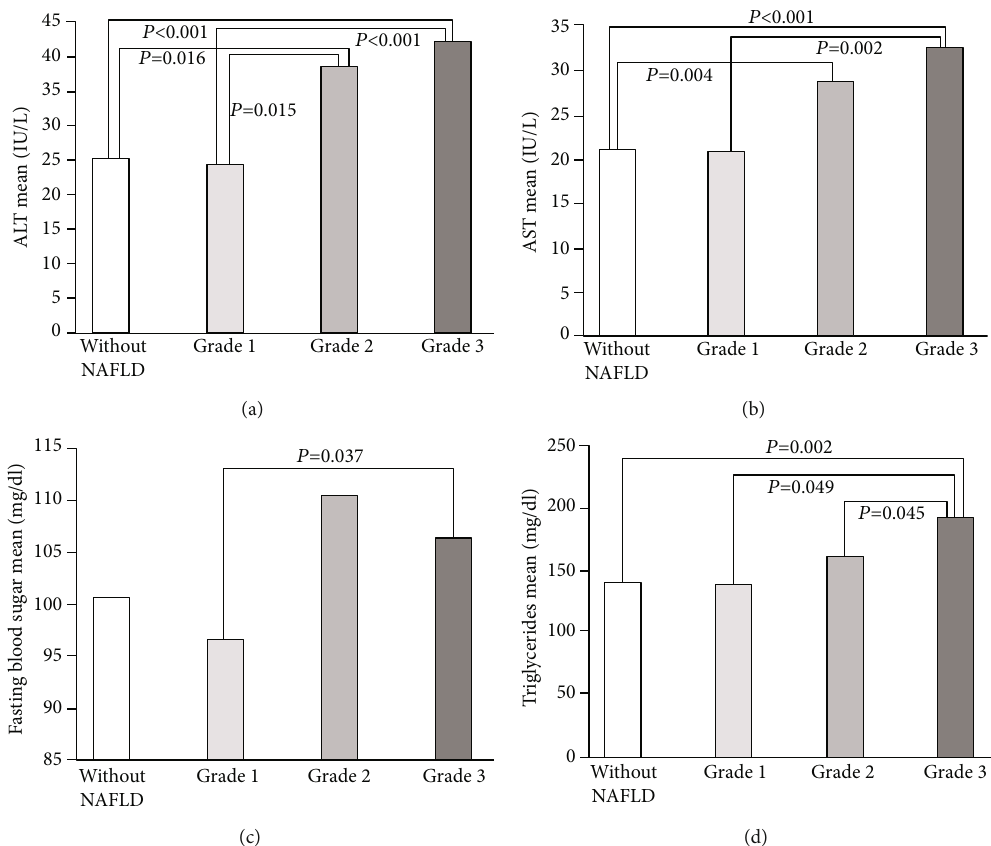
Figure 1: The means of (a) alanine aminotransferase (ALT), (b) aspartate transaminase (AST), (c) fasting blood sugar (FBS), and (d) triglycerides (TGs) in the patients with and without NAFLD undergoing bariatric